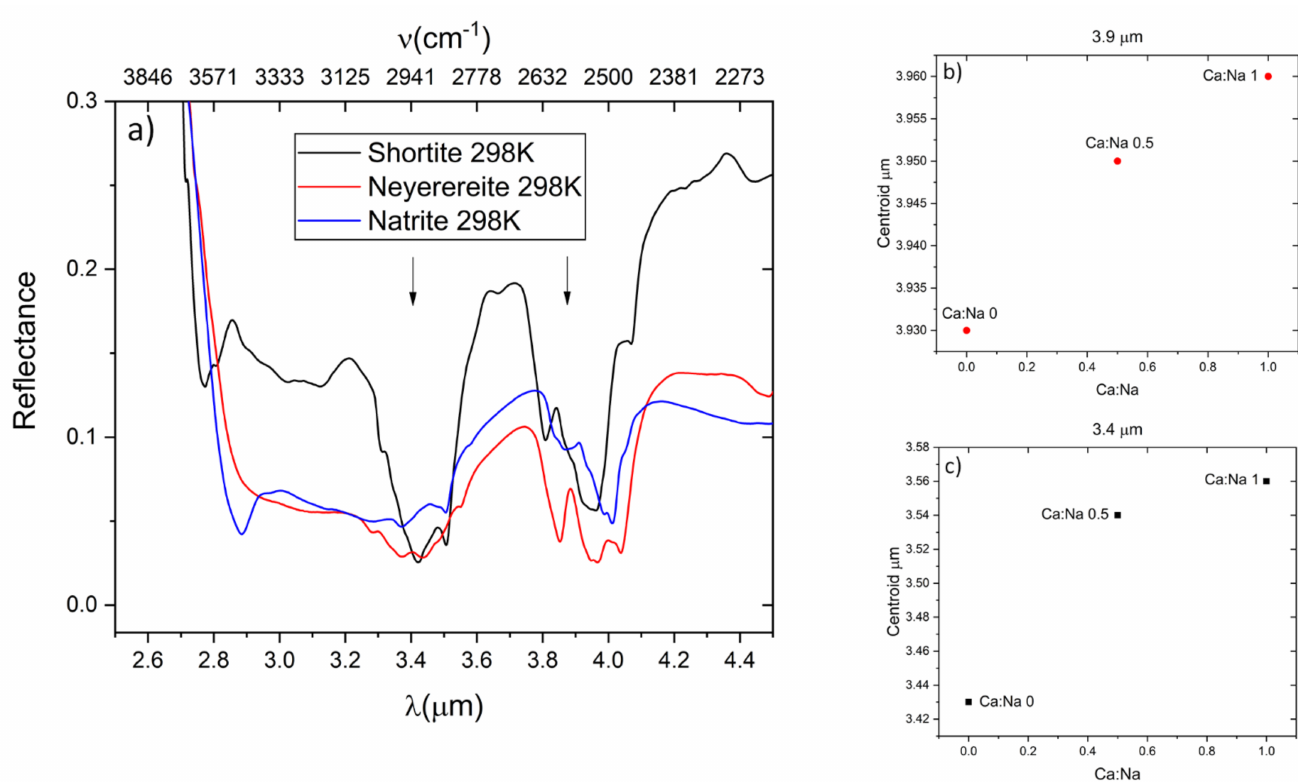
Figure 12. Comparison of 3.4 and 3.9 µ m bands (underlined by arrows) for shortite, nyerereite, and natrite minerals in relation to the different Na:Ca ratio ( a ). The centroid variation is reported in ( b ) and ( c